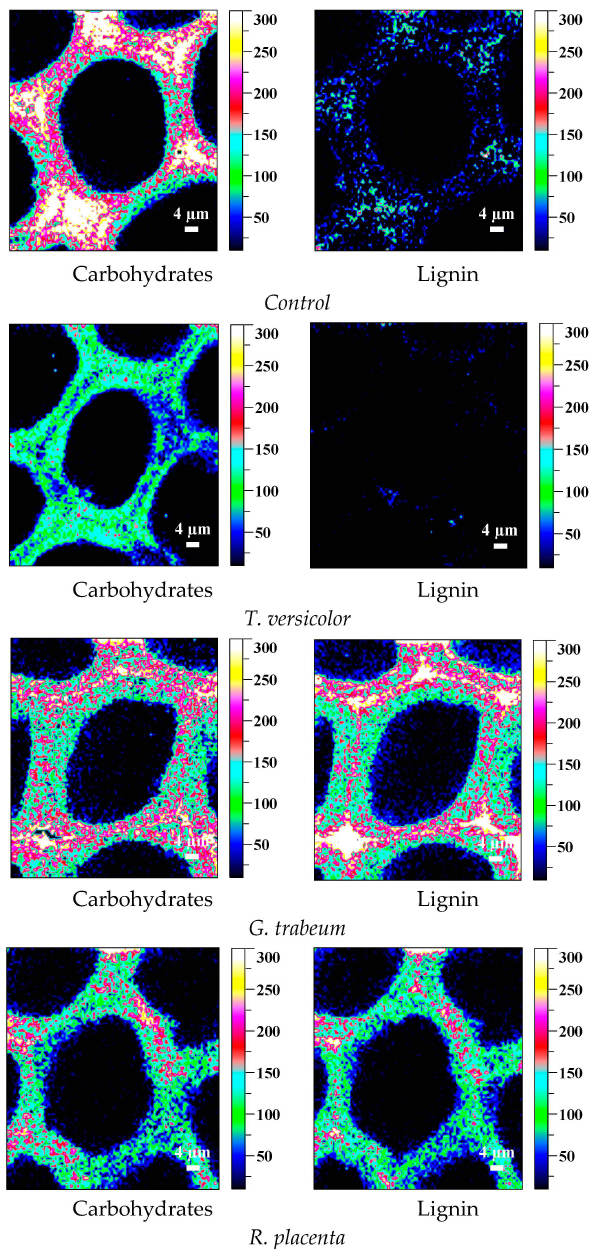
Figure 6. Raman images of Pinus yunnanensis samples converted by different fungi for 16